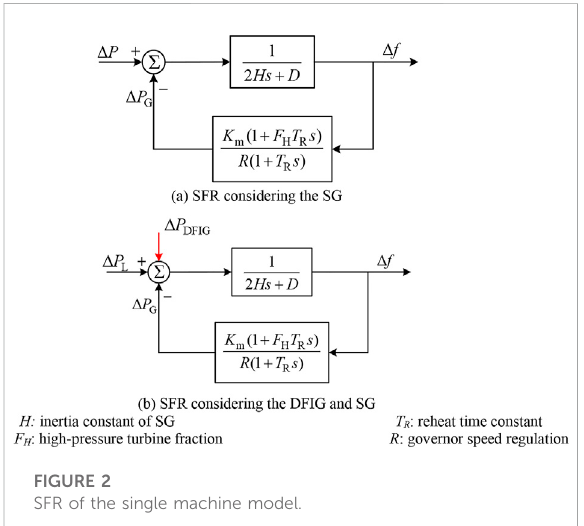
Operational concepts of the conventional stepwise IC